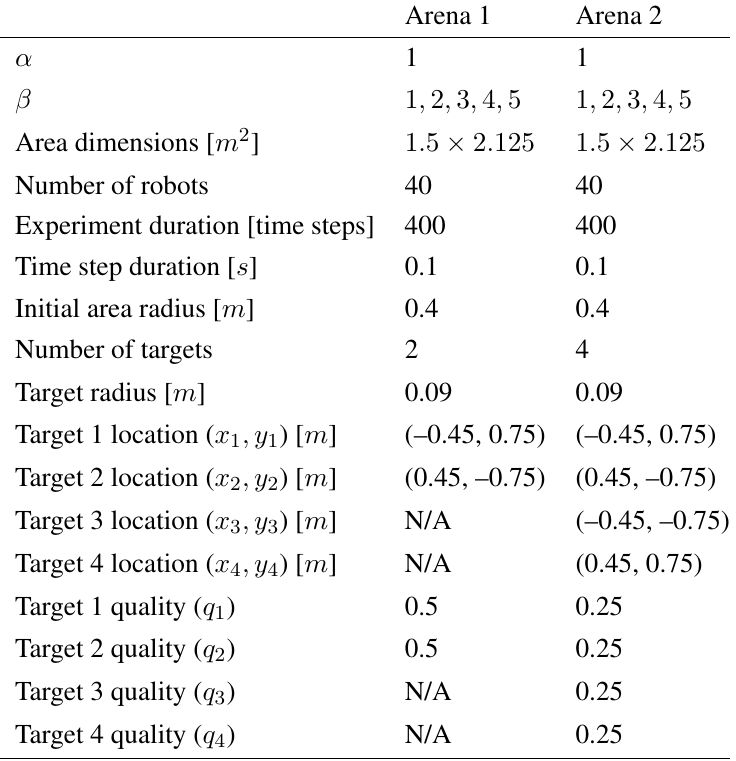
Table 1. Parameters describing Experimental Setup 1.